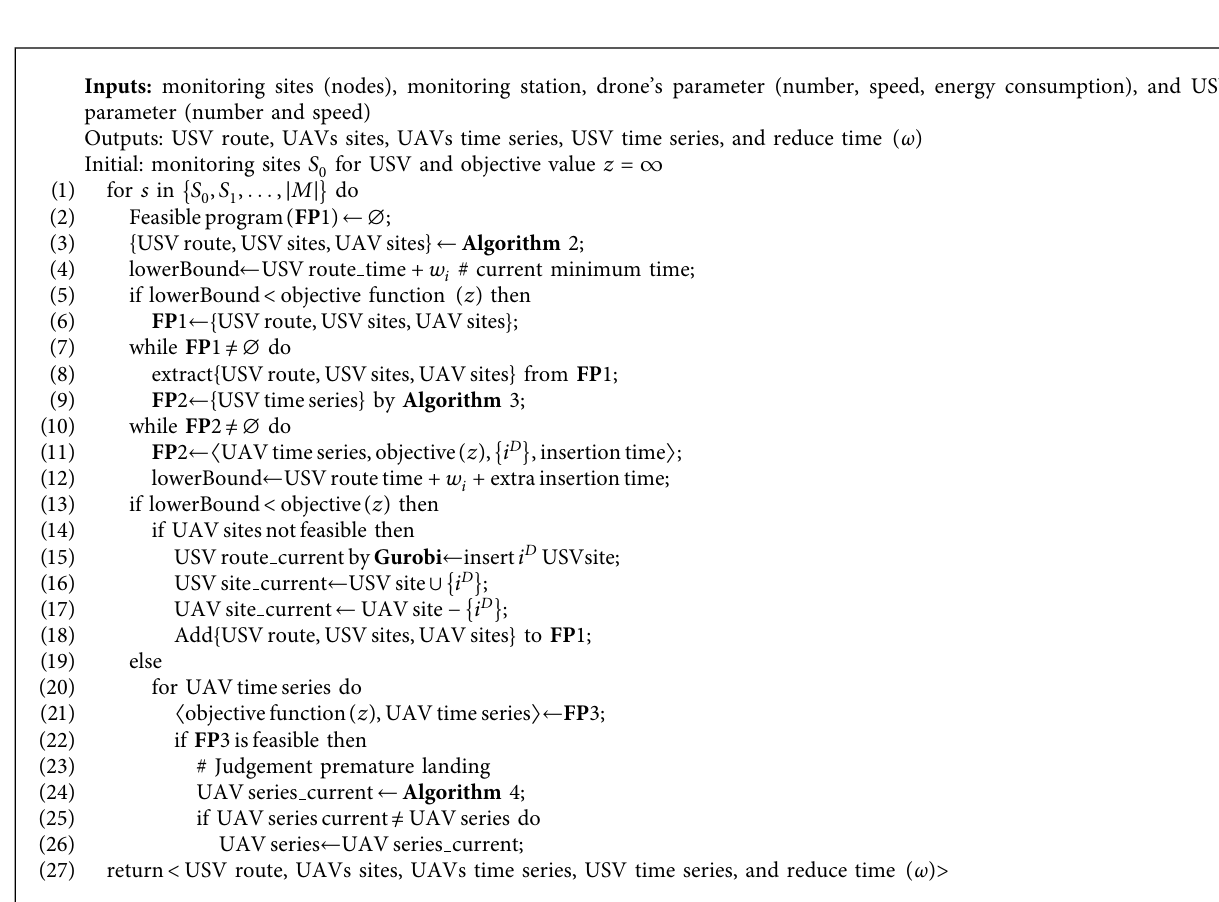
Figure 3: A framework for MFSDCP heuristic.